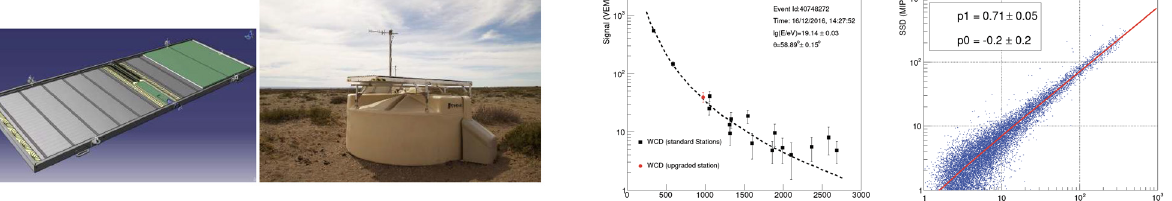
array in close proximity to the EA. The reconstructed signals in the EA are compared with the LDF of the event. Right: correla- tion of the signals of the SSD and the WCD. Both signals have been